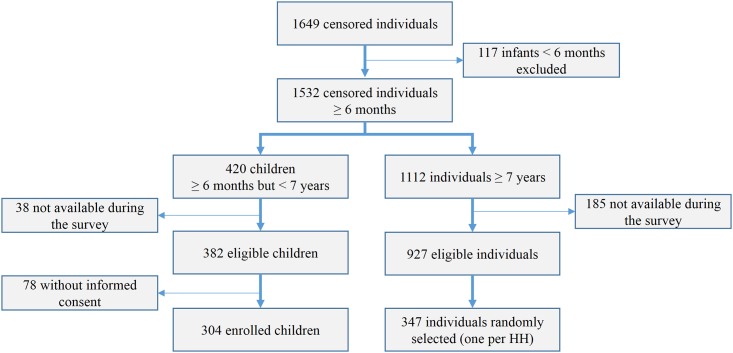
Flowchart of study participants.